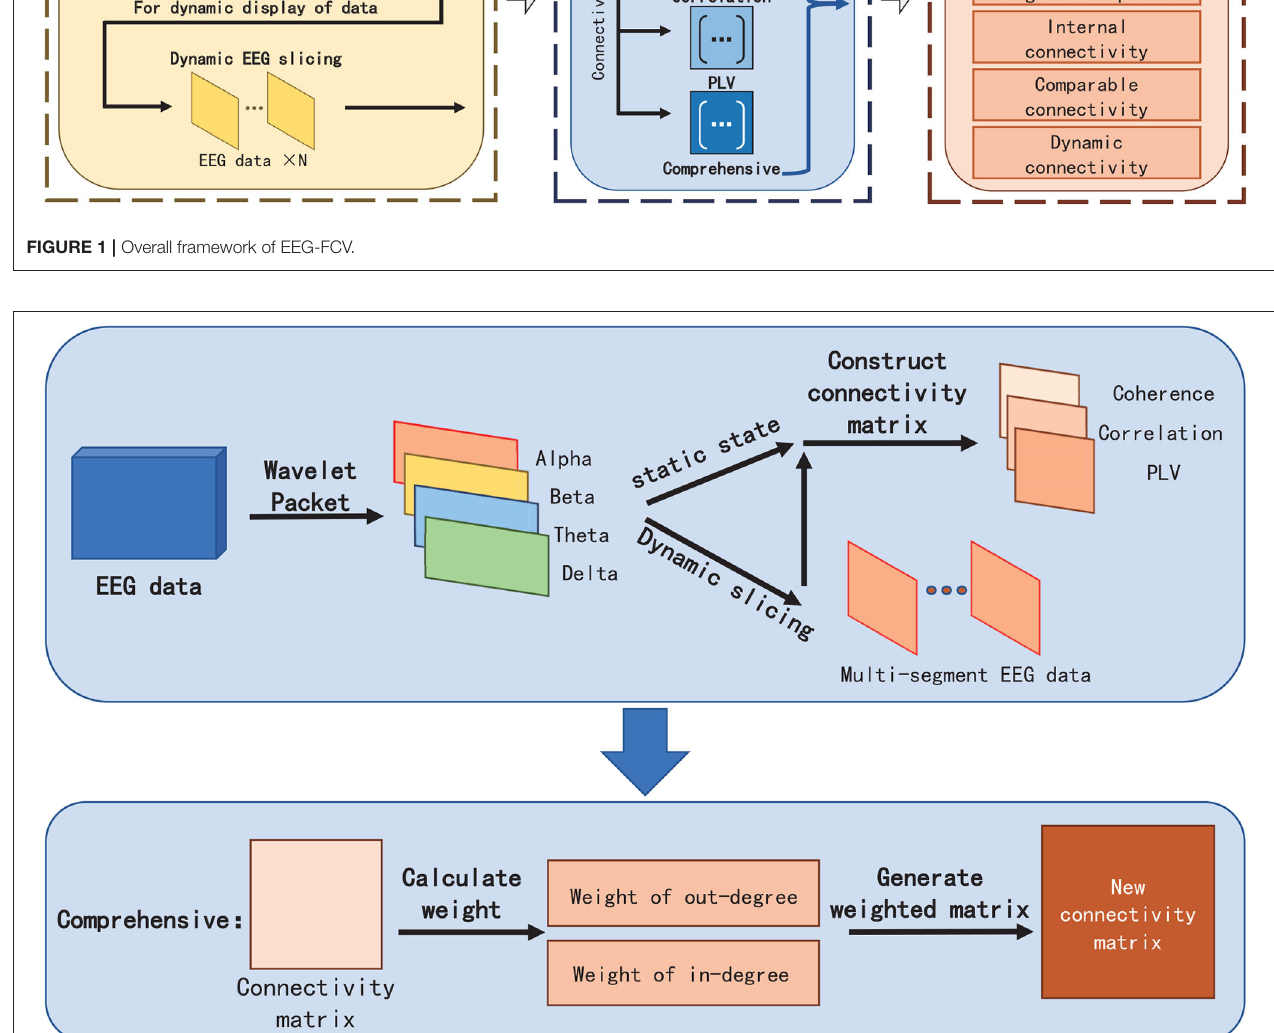
FIGURE 2 | Work flow of